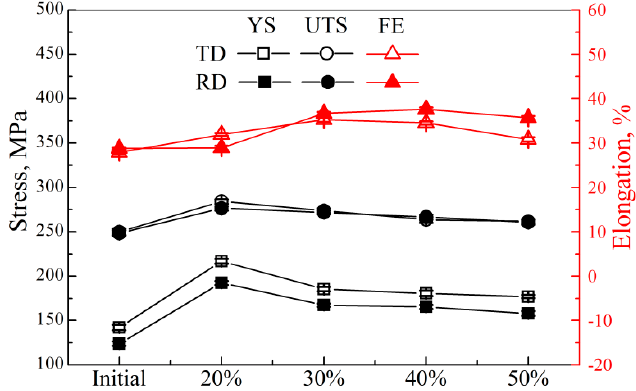
Figure 11. Stress variation and fracture elongation variation with the increase of thickness reduction at a given rolling temperature of 400 ◦ C (YS: yield stress, UTS: ultimate tension stress, FE: fracture elongation). Table 2. Summarized mechanical properties of AZ31 magnesium alloy sheets rolled at 400 °C (YS: yield stress; UTS: ultimate tension stress; FE: fracture elongation).